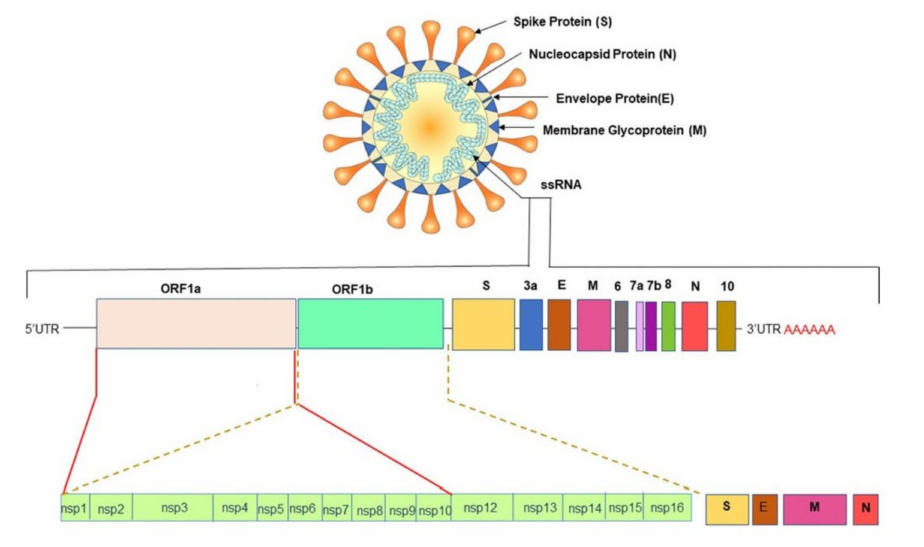
Figure 1. Schematic presentation of spherical genome structure of the SARS-CoV-2. Reprinted with permission from [29]. Copyright 2020